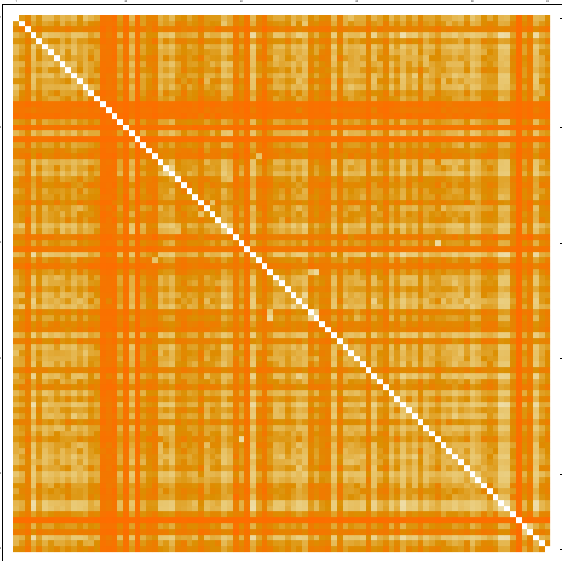
Fig. 2 The matrix of correlation distance among the financial agents of XU 100. The darker points are closer to 1 while the lighter ones are closer to